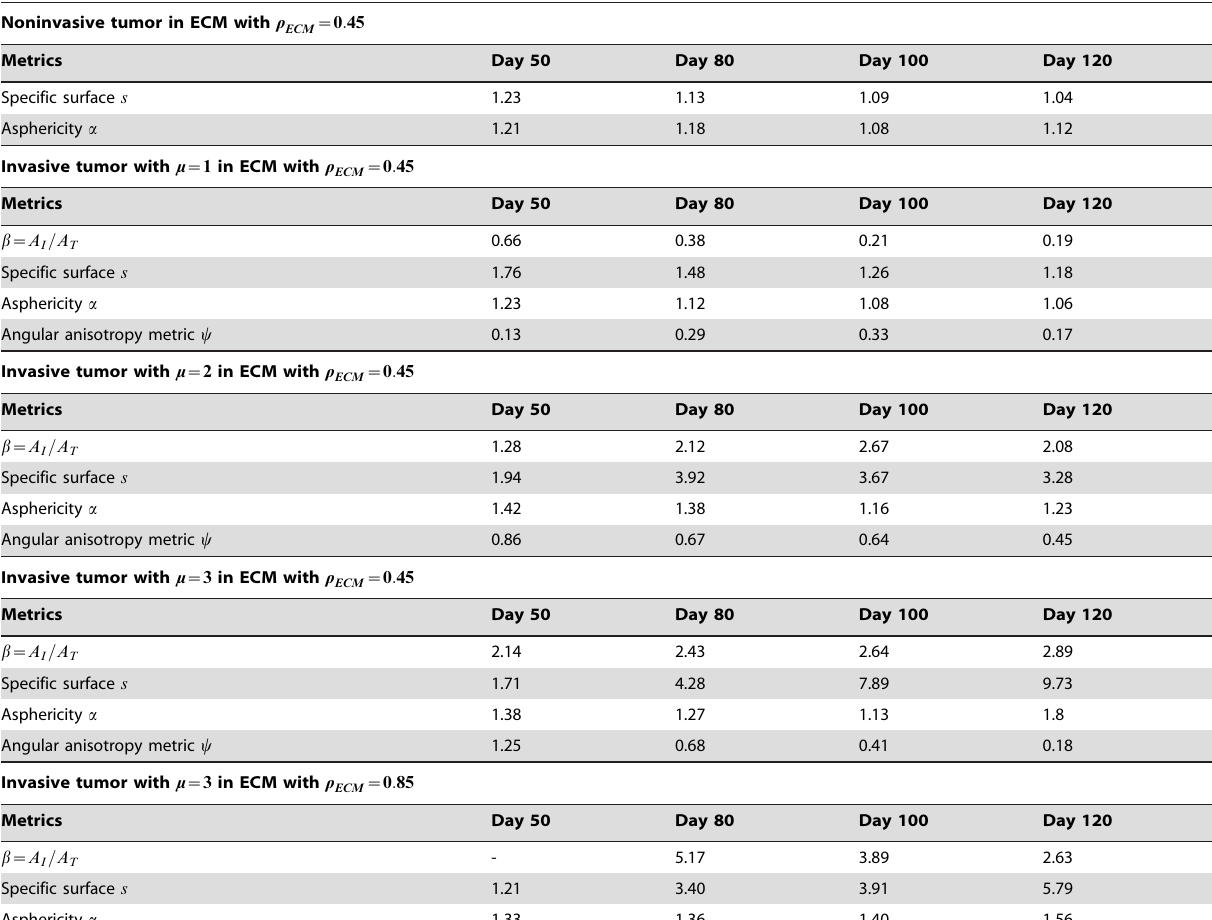
Table 3. Morphology metrics for simulated tumors growing in homogeneous